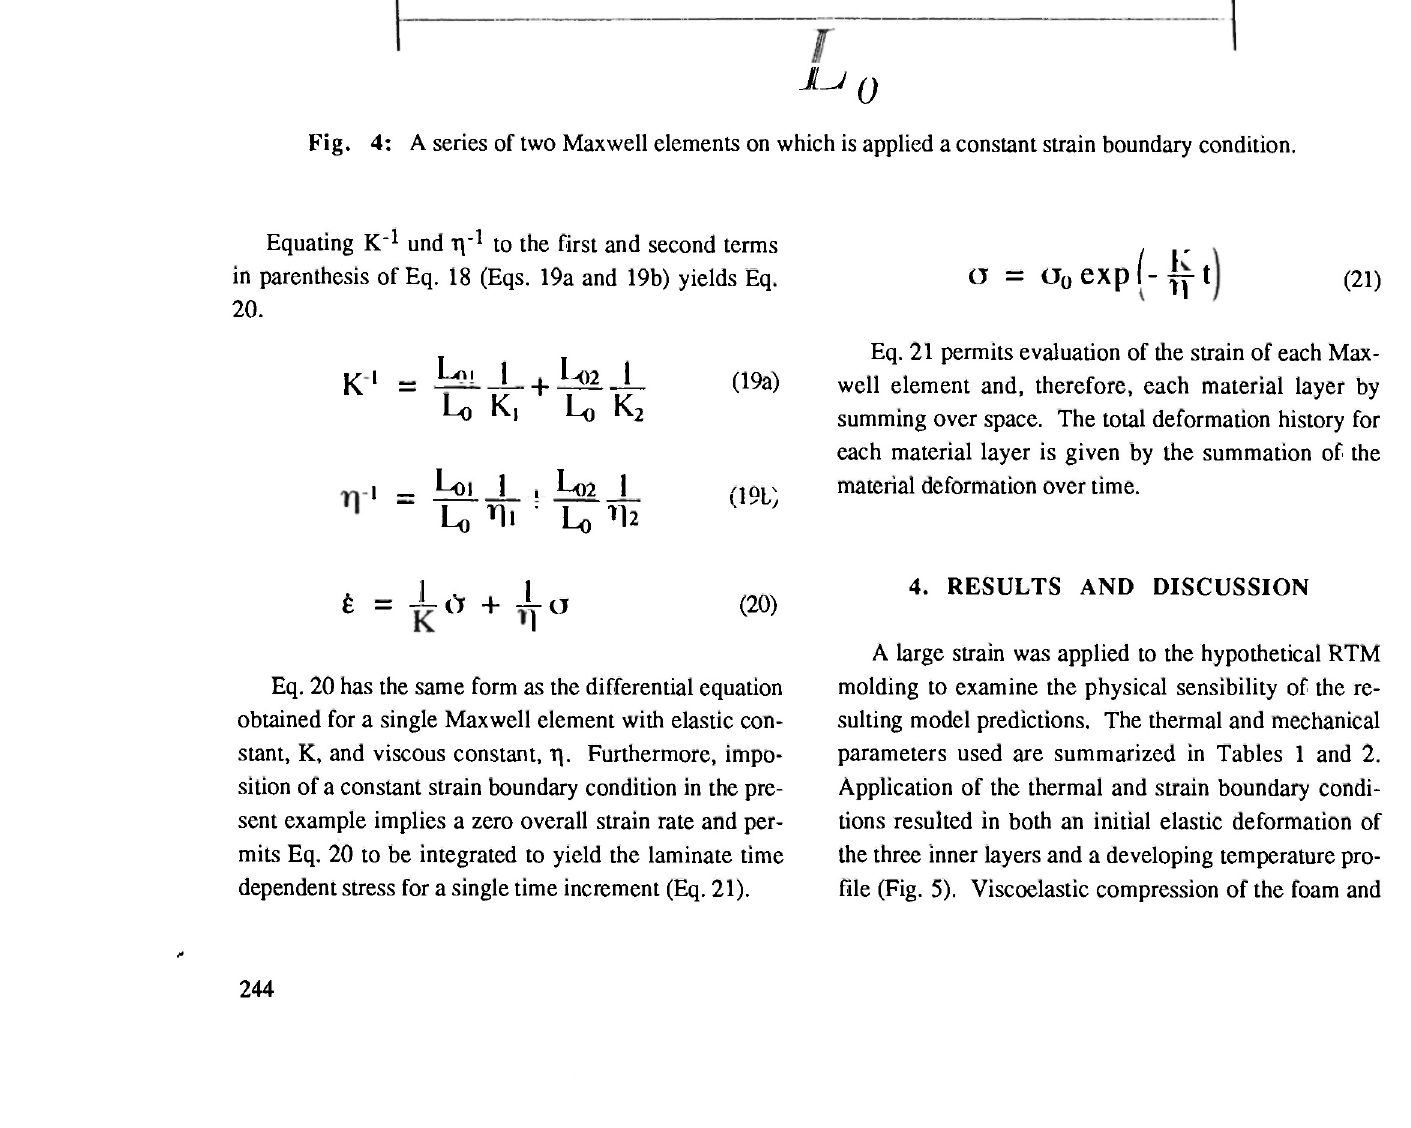
Fig. 4: A series of two Maxwell elements on which is applied a constant strain boundary